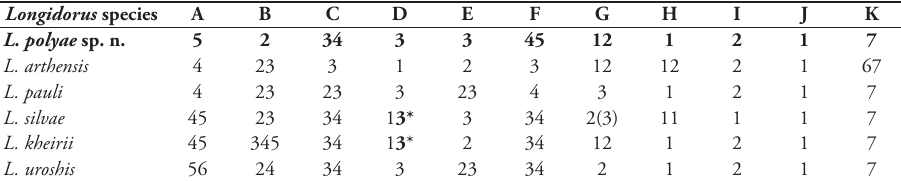
Table 2. A partial polytomous key to the species of Longidorus species close to L. polyae sp. n., based on the key by Chen et al. (1997) and Peneva et al. (2013) incorporating species described after 1997. Longidorus